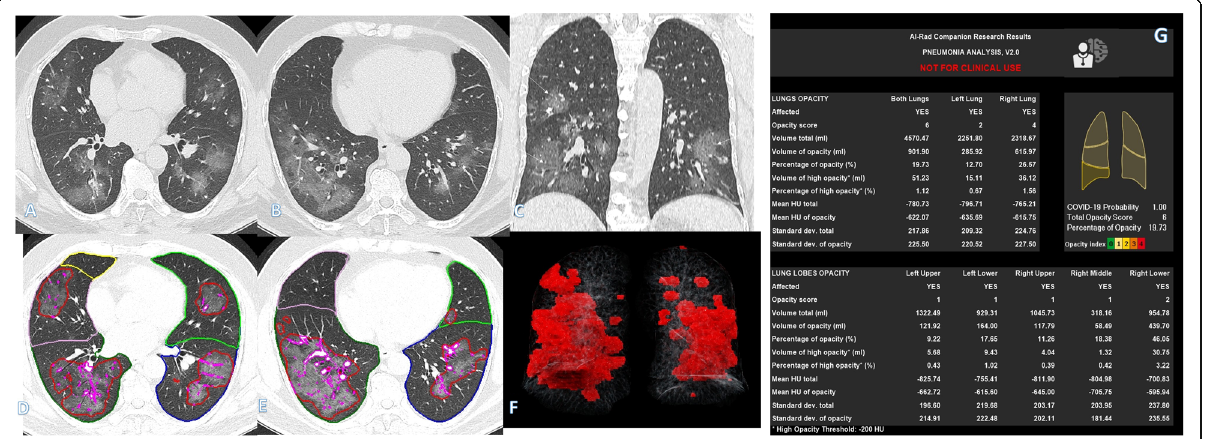
Fig. 3 A 61-year-old male with positive COVID-19 virus. CT chest shows bilateral scattered random ground-glass opacities (arrows) with more involvement of the right lower lobe (arrows in a – c ). Total severity score = 7. Quantitative analysis by AI-Rad Companion Research CT Pneumonia Analysis was presented ( d – g ) with the measured parameters seen in table ( g ). Quantitative total opacity score was